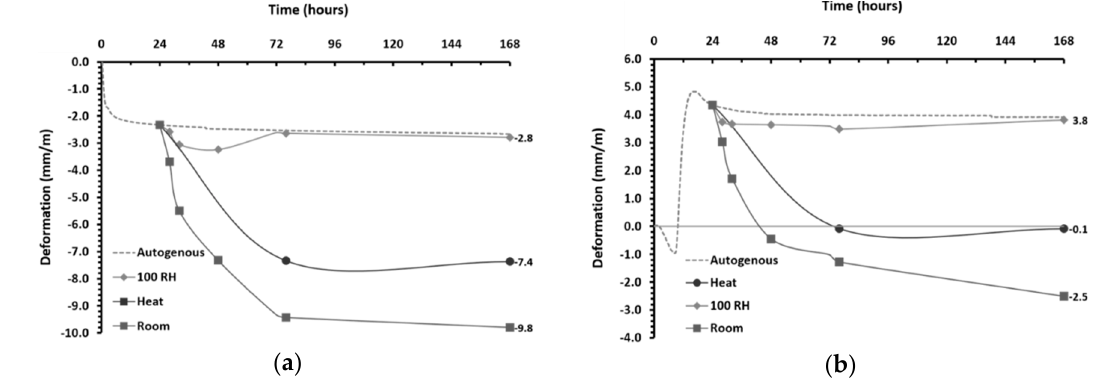
Figure 8. Combined representation of autogenous and total shrinkage of alkali-activated mortars cured under different conditions: ( a ) PS mortars and ( b ) KO mortars.